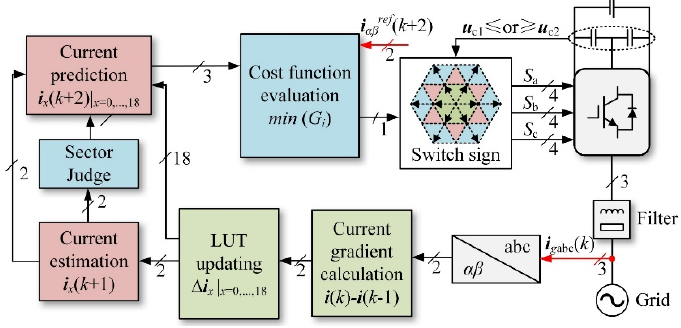
Figure 6. Control block diagram of the proposed MFPC scheme.